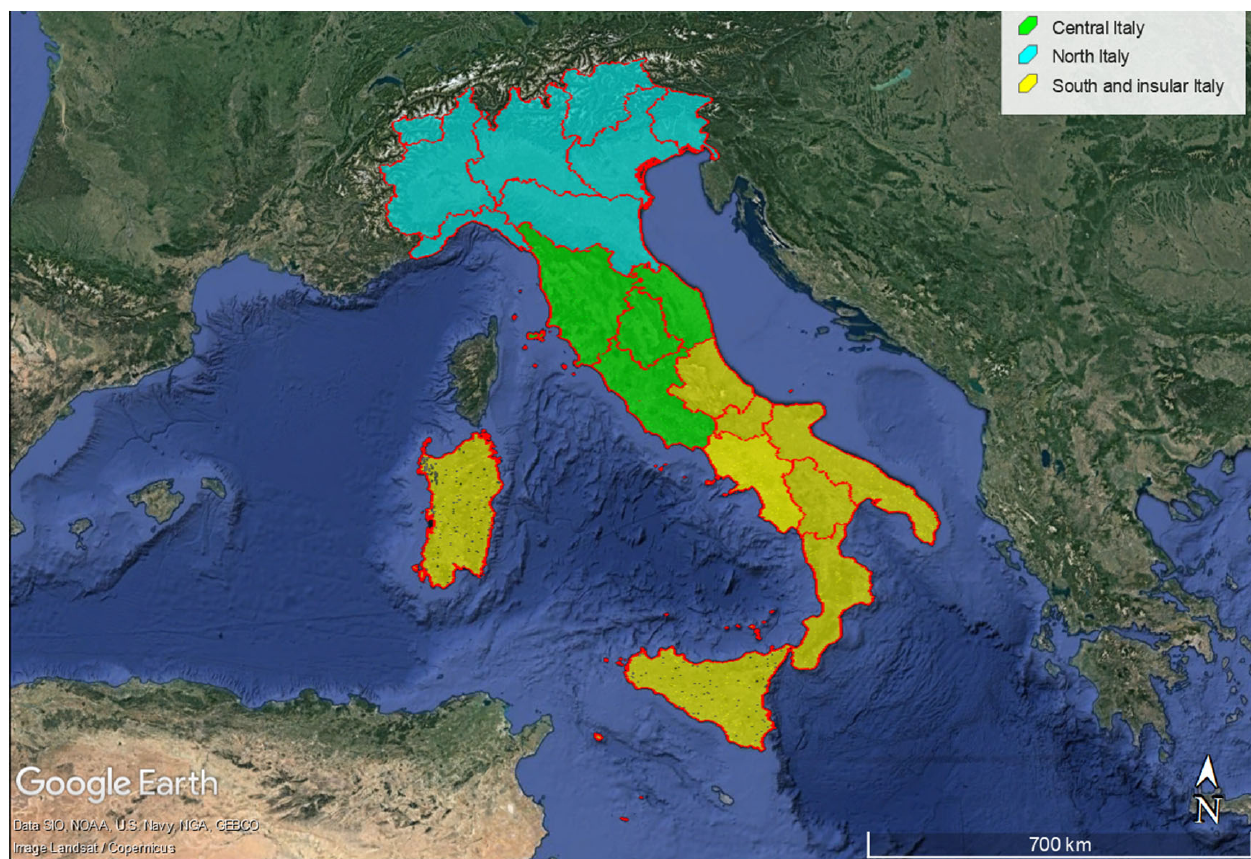
Figure A1. Location of Italy and the Italian macro-regions considered for exposure evaluation.